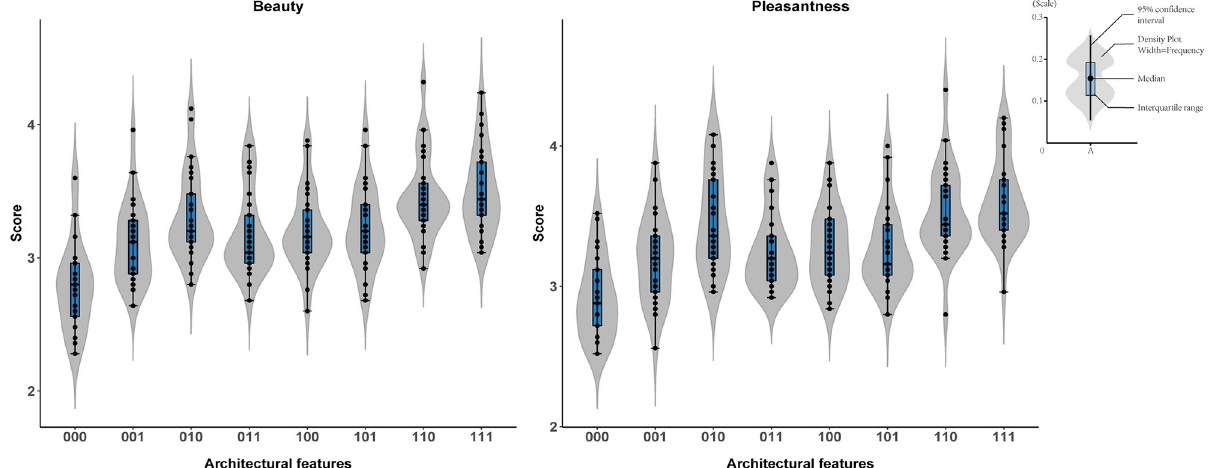
Fig 3. Beauty and pleasantness rating. The first digit in the x-axis represents the ceiling height, the second digit represents the degree of openness, and the third digit represents the contour type. In the violin plot, the box in the middle indicates the interquartile range, and the vertical line covers the 95% confidence interval.